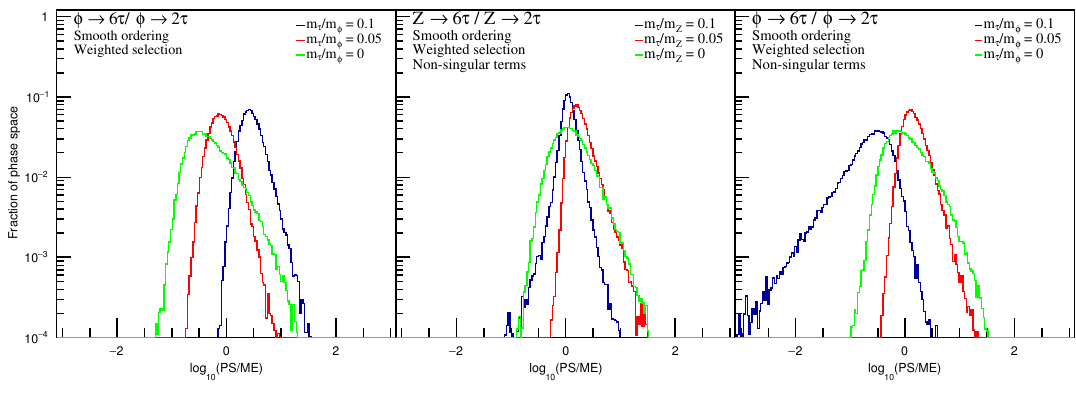
Figure 8 . Illustration of the impact of non-singular terms on the comparison between the parton shower approximation and matrix element calculations for two emissions and two splittings. In the left-hand graph, the Z -boson is replaced with a scalar that decays to a fermion-antifermion pair. In the middle and right-hand graph, the same comparison is repeated for the decay from both a Z and a (cid:30) , but the splitting antenna function now includes non-singular